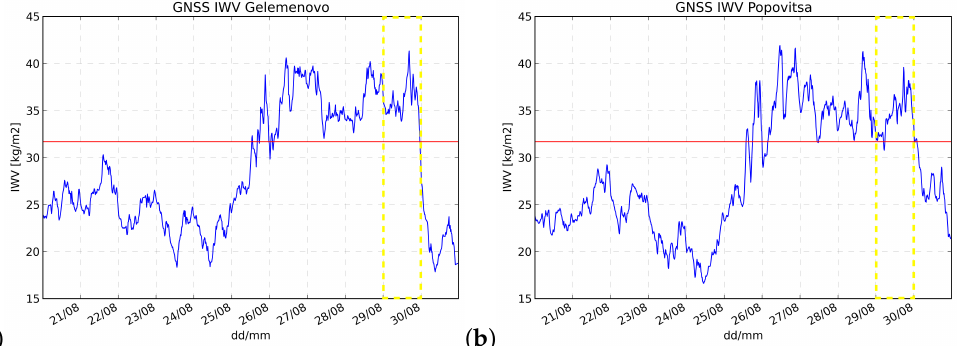
Figure 7. GNSS IWV at ( a ) Gelemenovo and ( b ) Popovitsa for the period 20–30 August 2021. The red line indicates the monthly IWV threshold for August. The dashed yellow line marked the day with “yellow” and the Meteoalarm code is issued by NIMH.